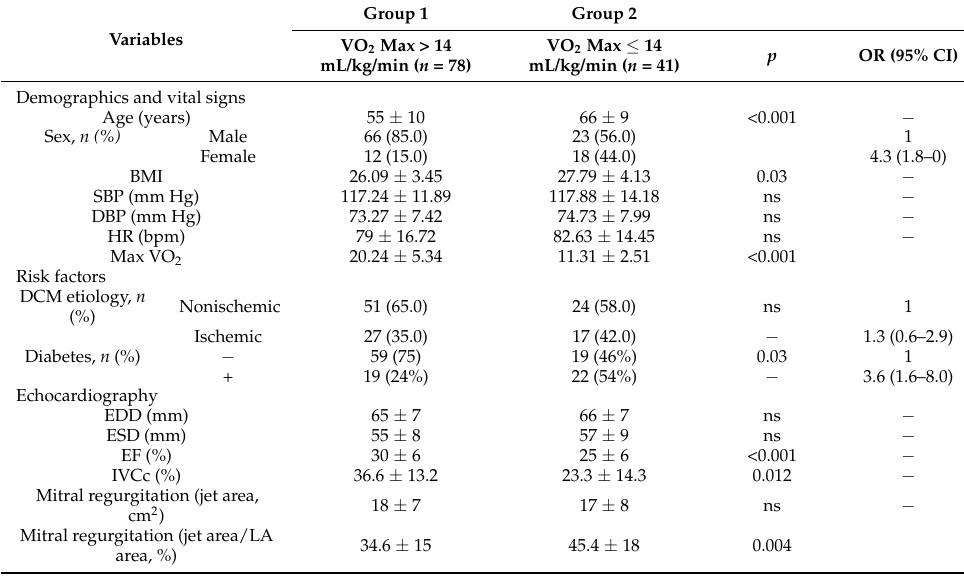
Figure 2. Flowchart explaining the enrolment criteria of our study group. DCM = dilated cardiomyopathy; pts = patients; NYHA = New York Heart Association functional classification; CPX = cardiopulmonary exercise testing. Table 3. Variables predicting peak VO 2 (univariate analysis).